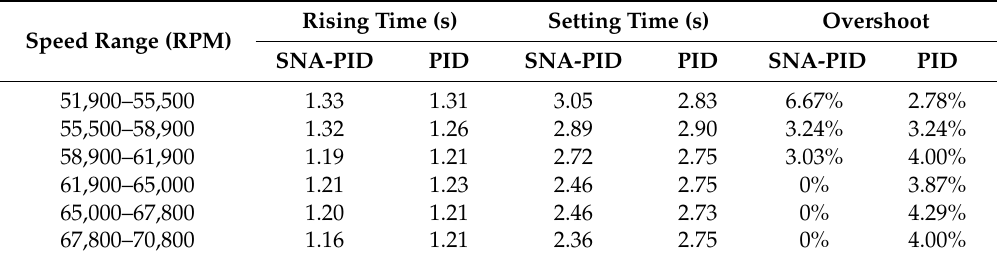
Table 3. Performance comparisons between SNA-PID and conventional PID.